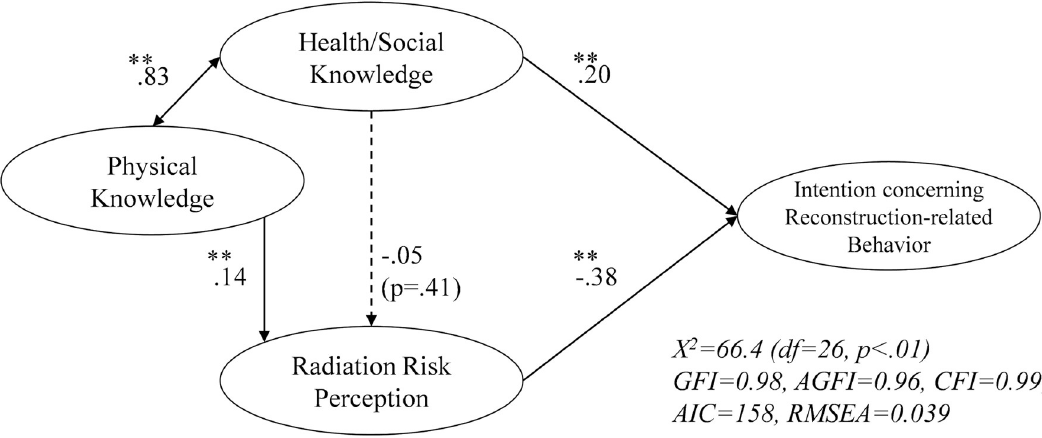
Fig 4. Estimated model of reconstruction-related behavior (NP group). �� p < .05. The respondents in NP group (n = 777) answered that Fukushima is not recovering or who were unable to